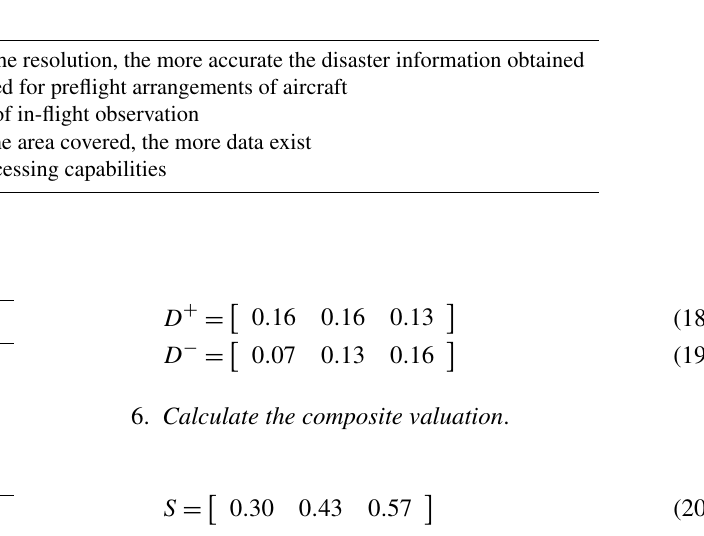
Table 5. Weighting of